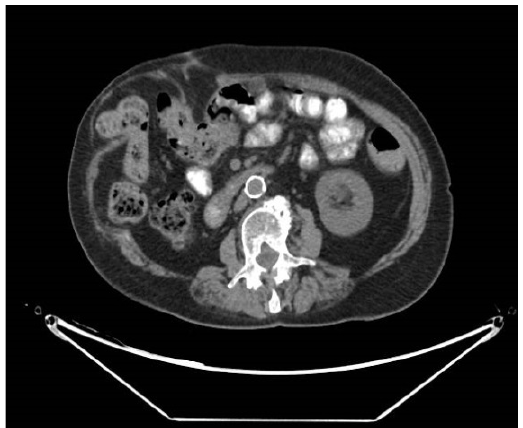
Figure 1. CT scan with incisional hernia in the right abdominal horizontal incision.